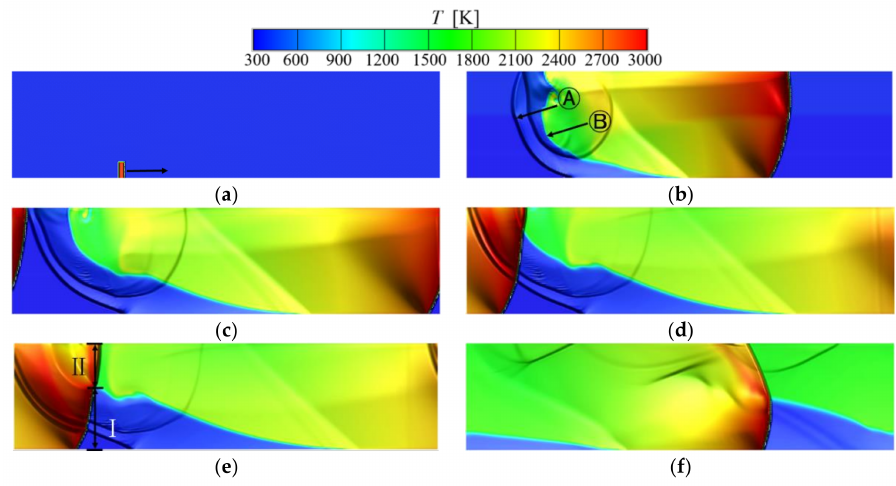
Figure 4. Temperature shadowgraphs of the CRD wave at different times: ( a ) t = 0 µ s; ( b ) t = 200 µ s;